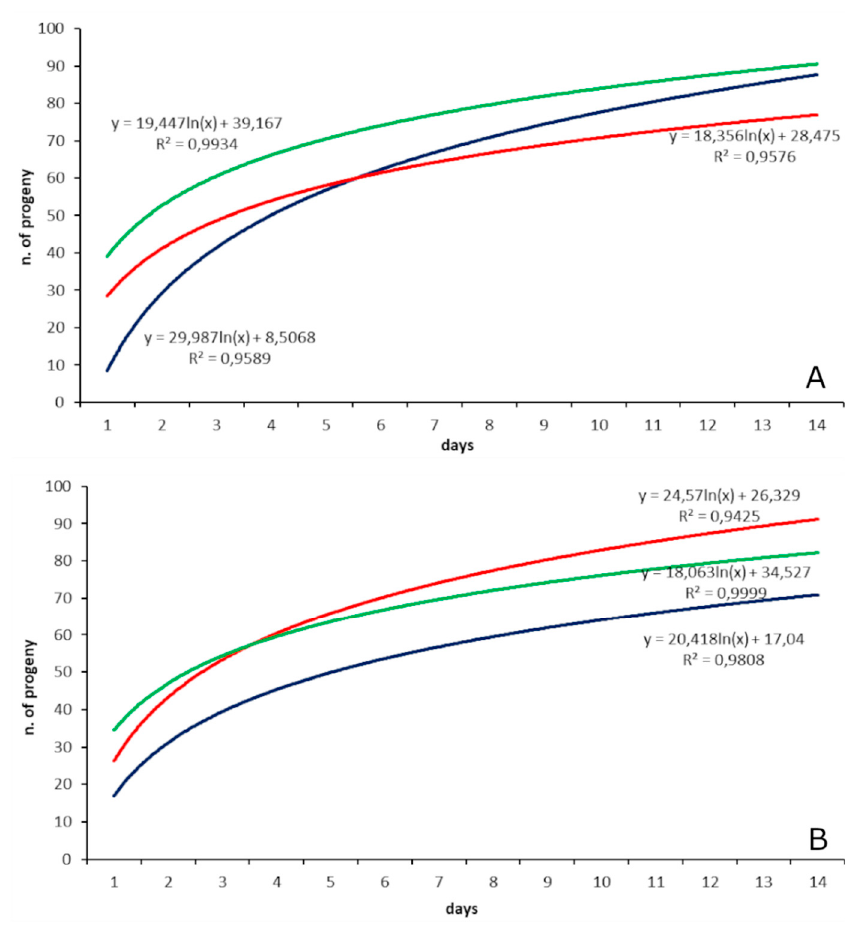
Figure 4. Trissolcus japonicus ( A ) and Trissolcus mitsukurii ( B ) CREA colonies: regression curves of the cumulative numbers of progeny/female under different supply regimes of Halyomorpha halys host egg masses. Green line = 1-day-old females with host egg masses offered daily for 10 consecutive days (1 d × 10 d); blue line = 7-day-old females (host deprived until day 7) with host egg masses offered daily for 10 consecutive days (7 d × 10 d); red line = 7-day-old females (host deprived until day 7) with host egg masses offered once a week for three consecutive weeks (7 d × 3 w); see text for more details.